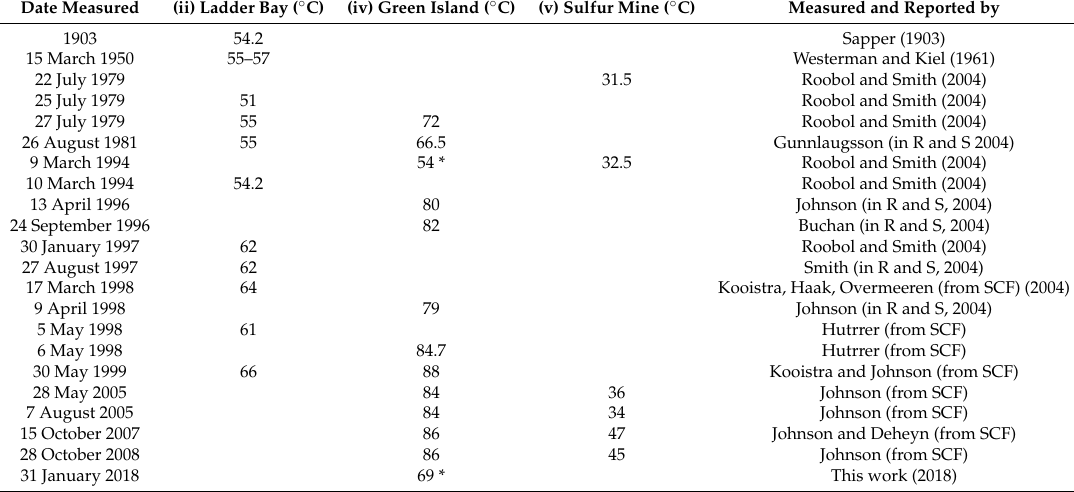
Table 3. Temperatures measured at the hot spring between Ladder and Tent Bay, the the hot spring opposite Green Island and inside the Sulfur Mine. * denotes the minimum temperature due to submersion of the spring. More recent numbers collected by the Saba Conservation Foundation